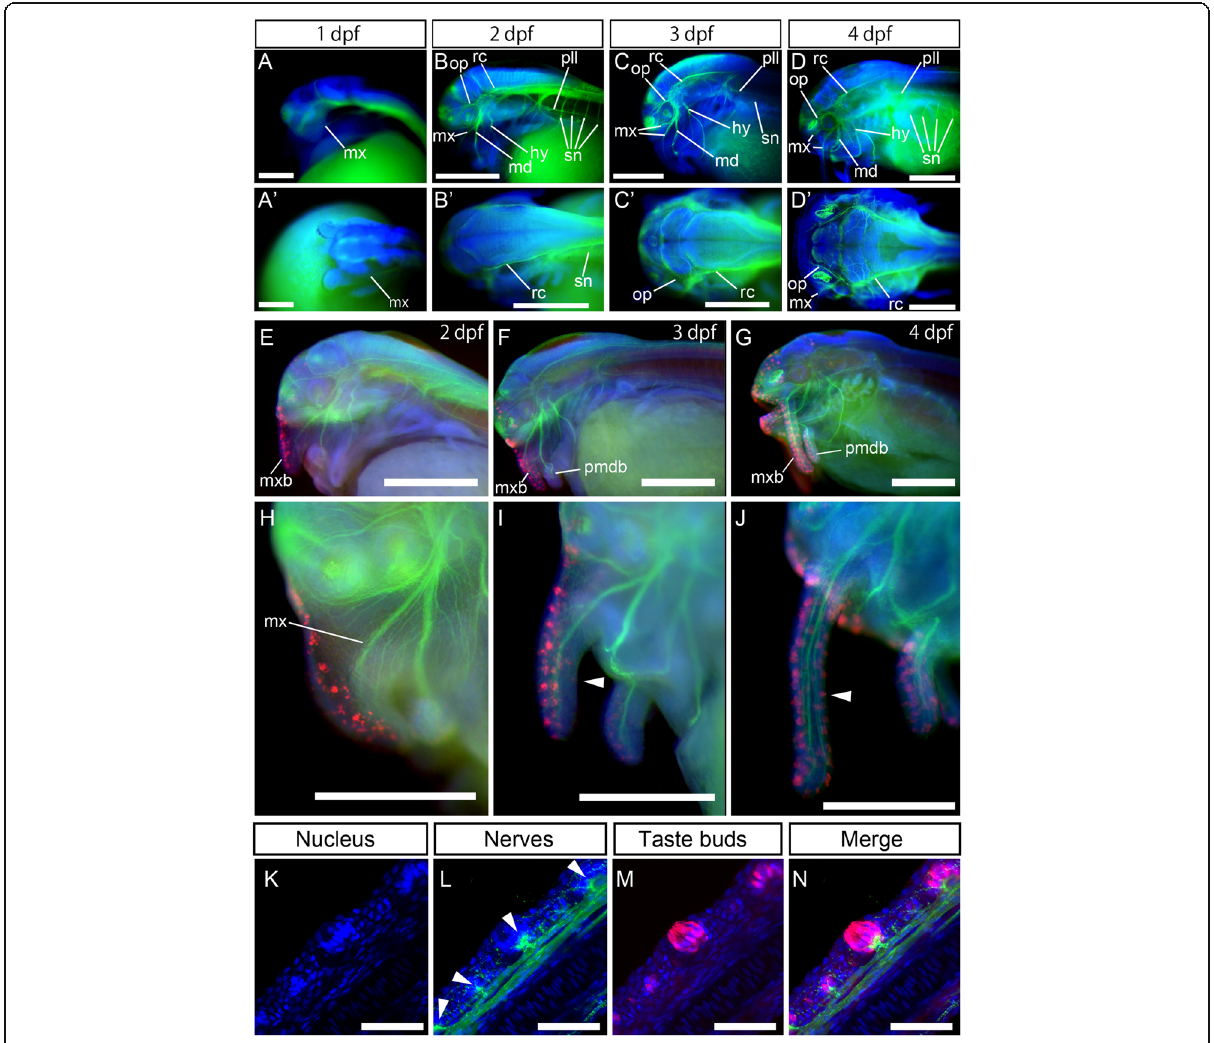
Fig. 3 Development of peripheral nerves in Amur catfish. Peripheral nerve axons stained by anti-acetylated tubulin antibody are shown in in green. Blue staining shows nucleus labeled by DAPI. Lateral views are shown in a – d and e – j. Dorsal views are shown in a ′– d ′ . Distribution of taste buds and innervation of peripheral nerves are shown in e – n. Arrowheads in i, j show maxillary barbels. Morphological relationships between taste buds and facial nerves on the barbel are shown in k – n. Peripheral nerve axons and taste buds were stained using anti-acetylated tubulin (in green) and anti-calretinin (in red) antibodies, respectively. Taste buds on catfish barbel are innervated by facial nerves and the nerve endings represent a specific “ loop ” (l, arrowheads). amdb, anterior mandibular barbel; mxb, maxillary barbel; hy, hyoid ramus of facial and anterior lateral line nerves; md, mandibular ramus of trigeminal and facial nerves; mx, maxillary ramus of trigeminal and facial nerves; op, ophthalmic ramus of trigeminal and facial nerves; pll, posterior lateral line nerve; pmdb, posterior mandibular barbel; rc, recurrent ramus of the facial nerve; sn, spinal nerves; Anterior is left in all images. Scale bars in a is 200 μ m, 500 μ m in b – j, and 50 μ m in k –